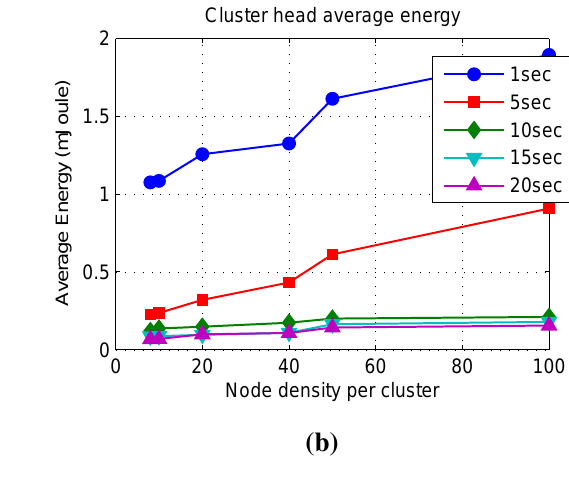
Figure 13. The average energy consumption of the sensor nodes and the cluster heads. ( a ) Sensor node average energy consumption; ( b ) cluster head average energy consumption.